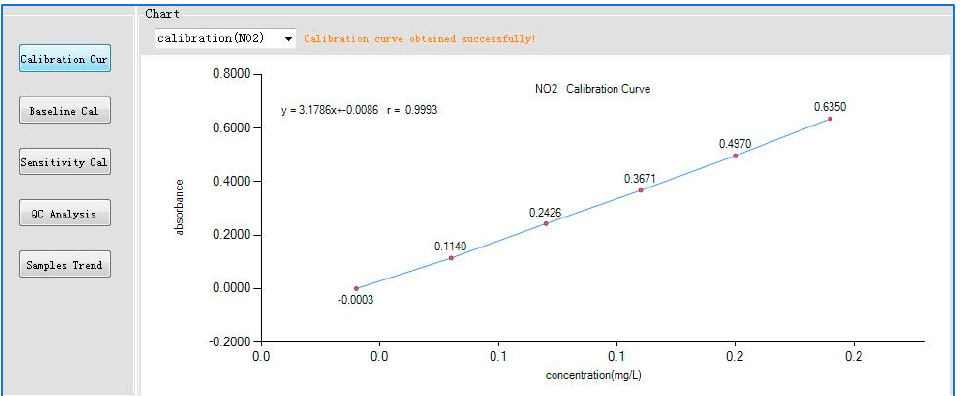
Figure 4. Data quality control module.